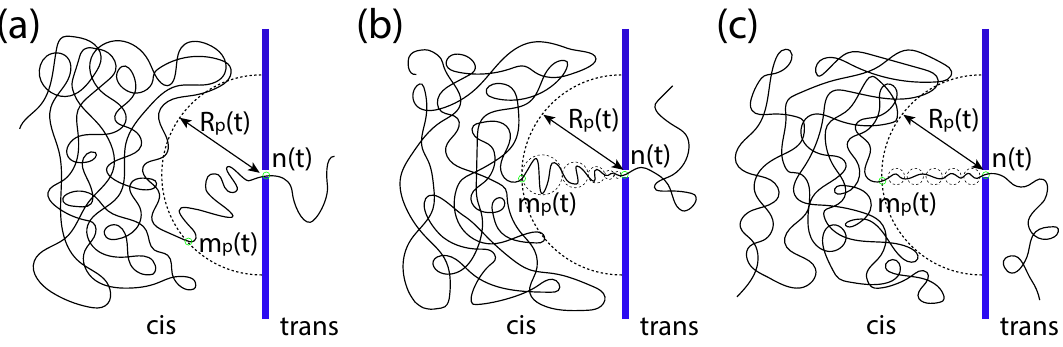
Figure 1. ( a ) A sketch illustrating the translocation coordinate n , the position of the tension front R p and the index of the monomer at the tension front, m p , at time t . ( b ) An illustration for the strongly-driven trumpet (SD(T)) force regime, showing the formation of the trumpet-like shape of chain segments between the tension front and the pore. ( c ) A drawing showing the formation of the isofluxed chain segments in the strongly-driven isoflux (SD(I)) force